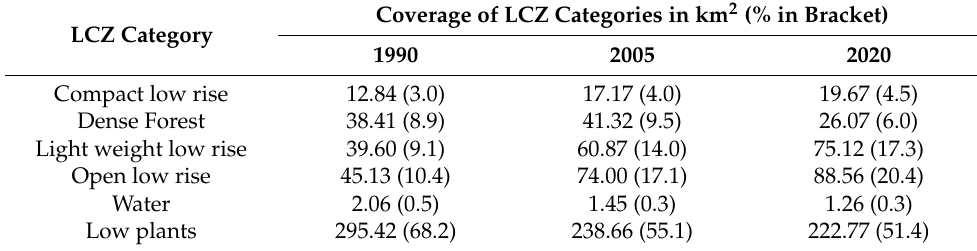
Table 2. Coverage of LCZ categories in 1990, 2005 and 2020.